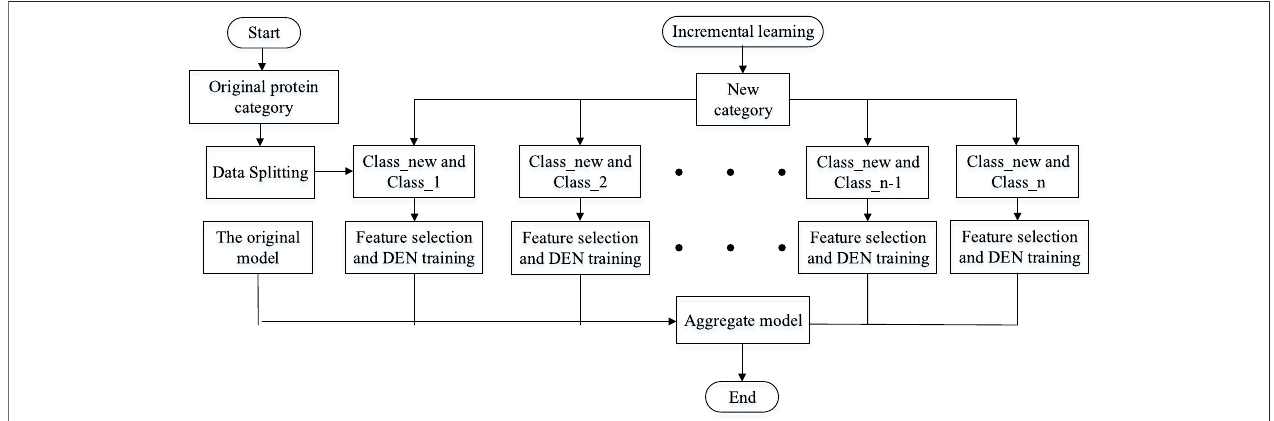
FIGURE 4 | The simple fl ow of the lifelong learning